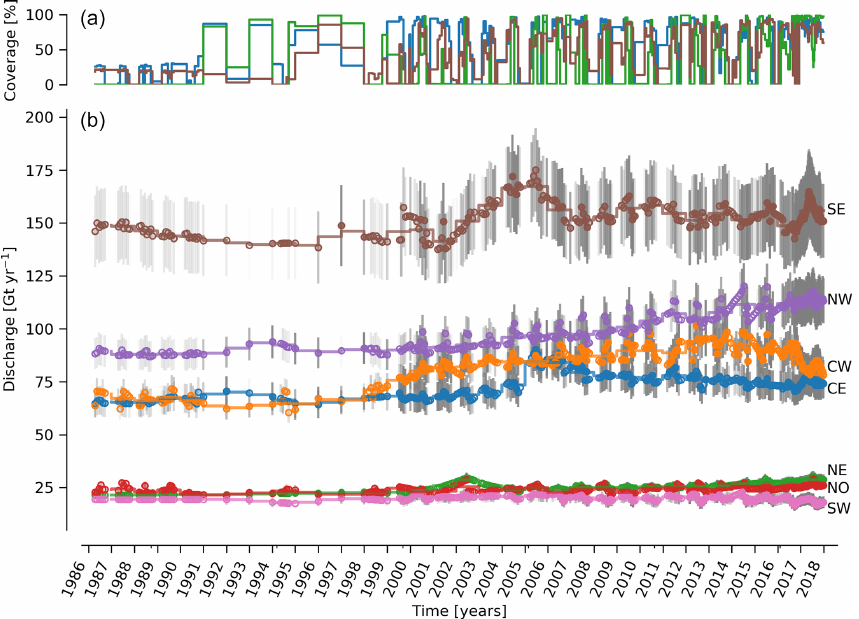
Figure 5. (b) Time series of ice discharge by region. Same graphical properties as Fig. 4. (a) The region with highest coverage (CE), lowest coverage (NE), and coverage for the region with highest discharge (SE) are shown. Coverage for other regions not shown to reduce clutter.